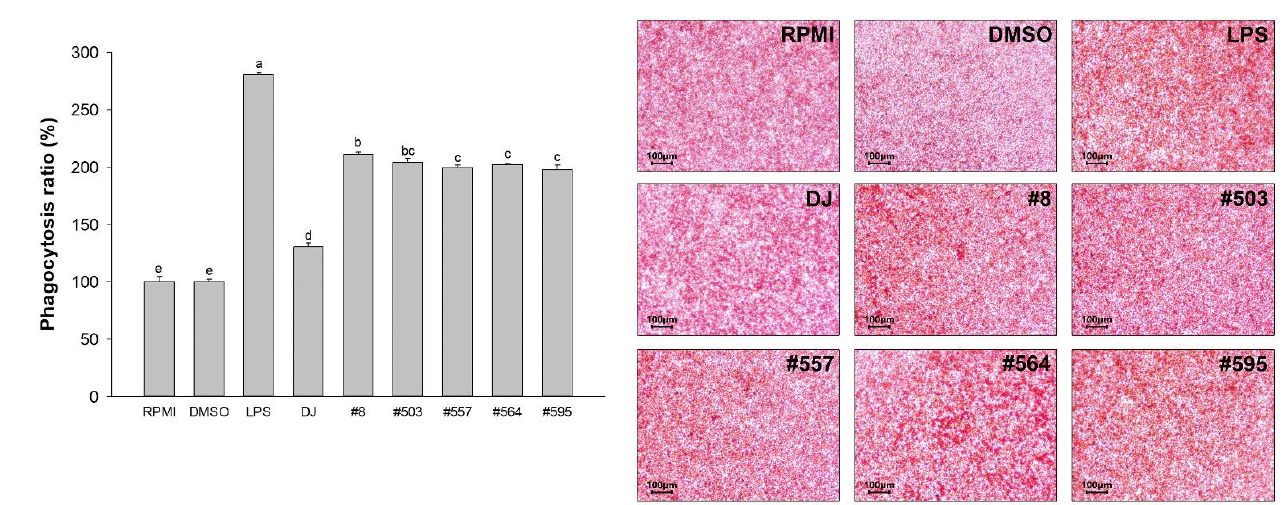
Figure 7. Effects of transgenic rice seed extracts (100 µg/mL) on phagocytosis activity in RAW264.7 cells. The concentrations of DMSO and LPS were 0.1% and 1 µg/mL, respectively. Data are presented as means ± standard deviations. Lowercase letters (a, b, c, d, and e) indicate significant differences at p < 0.05 among the treatments.